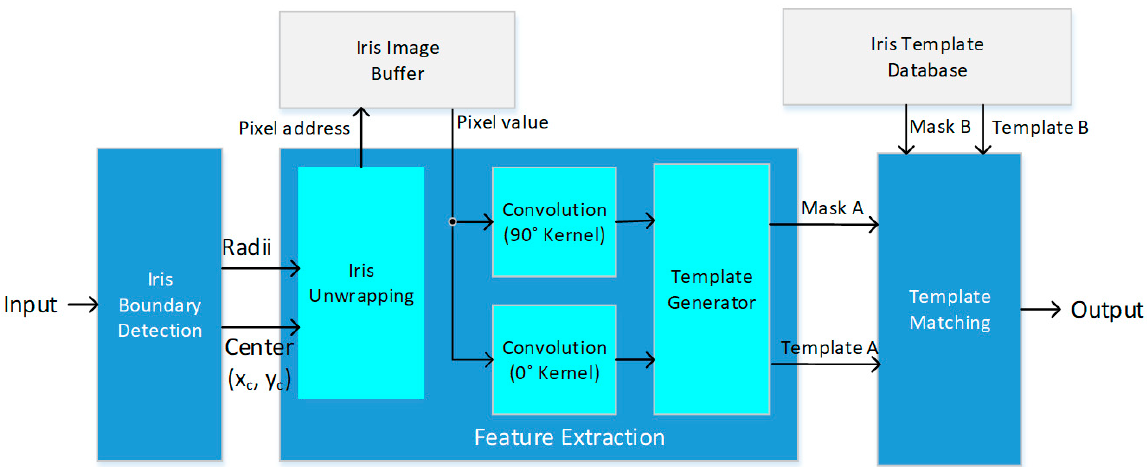
Figure 2. Block diagram of the architecture design for the feature extraction and template matching processes in the iris recognition algorithm.